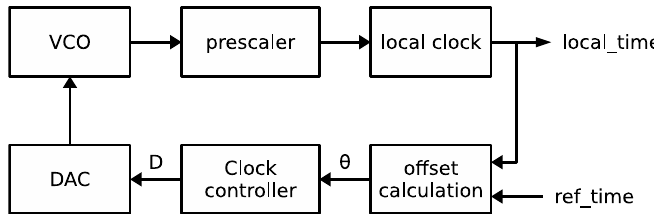
Figure 8. Traditional computer clock model based on a voltage-controlled oscillator